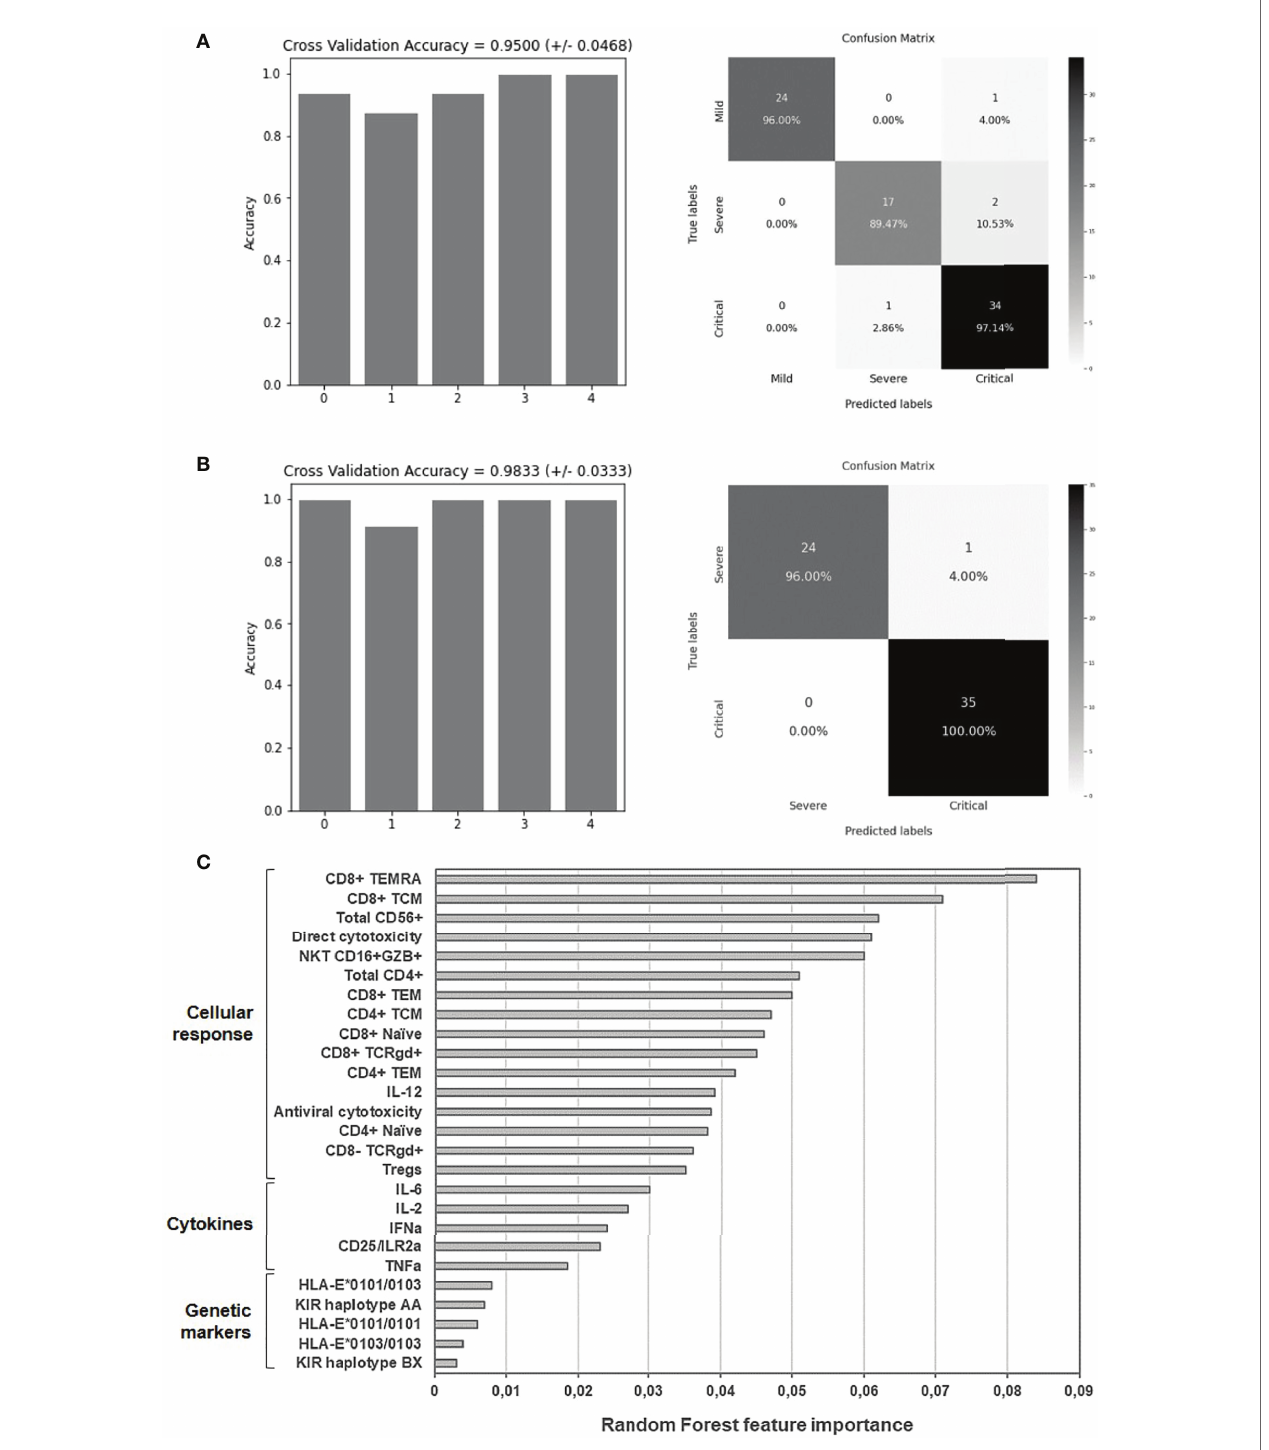
FIGURE 6 | Application of random forest algorithm and Gini VIM method to evaluate the accuracy and importance of the selected biomarkers to predict the worst progression of COVID-19. Accuracy for the 5 iterations of the outer loop of the nested K-fold cross validation and confusion matrix confronting the conditions predicted by the algorithm and the true severity-related conditions of patients with mild, severe and critical COVID-19 (A) or with severe and critical COVID-19 (B) . (C) Relative importance of the selected immunological parameters for the categorization of patients with mild, severe and critical COVID-19, according to Gini VIM